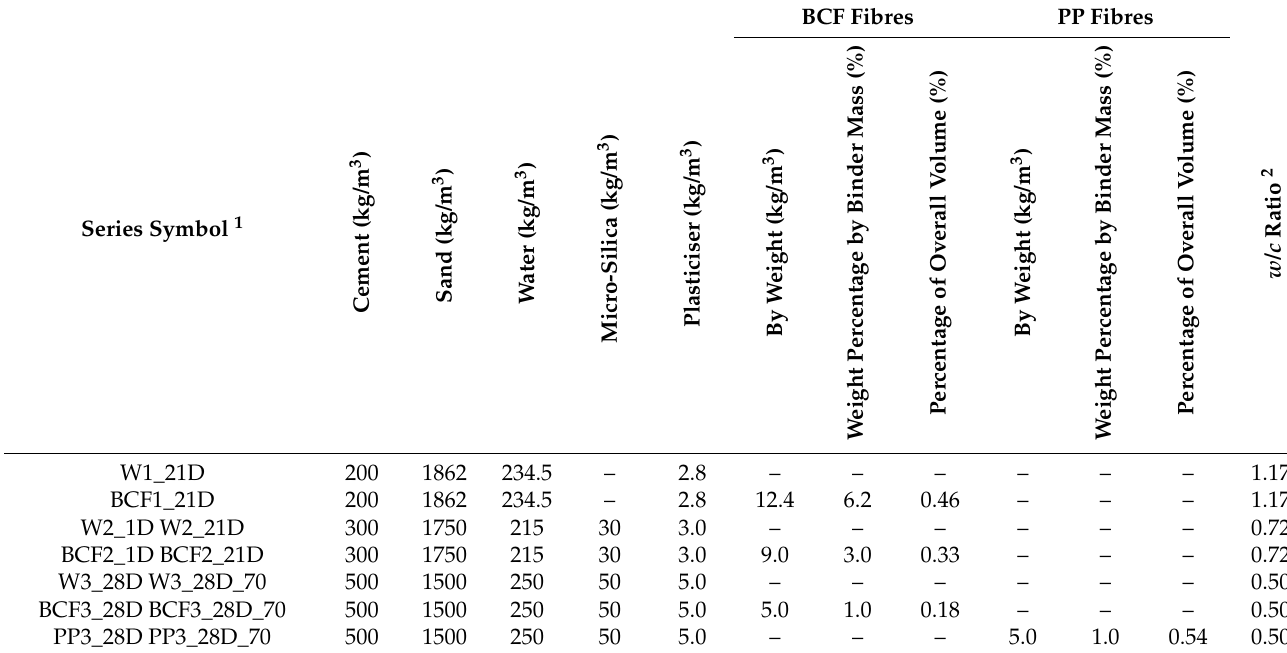
Table 3. Composition of the experimental